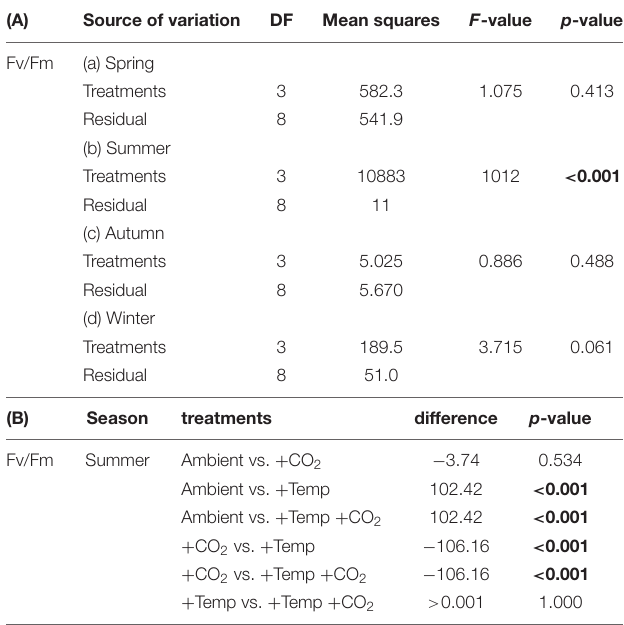
TABLE 3 | Results of (A) one-way ANOVAs and (B) Tukey’s test for effects of manipulated temperature and CO 2 conditions on maximum quantum yields (F v /F m ) in Fucus vesiculosus over different